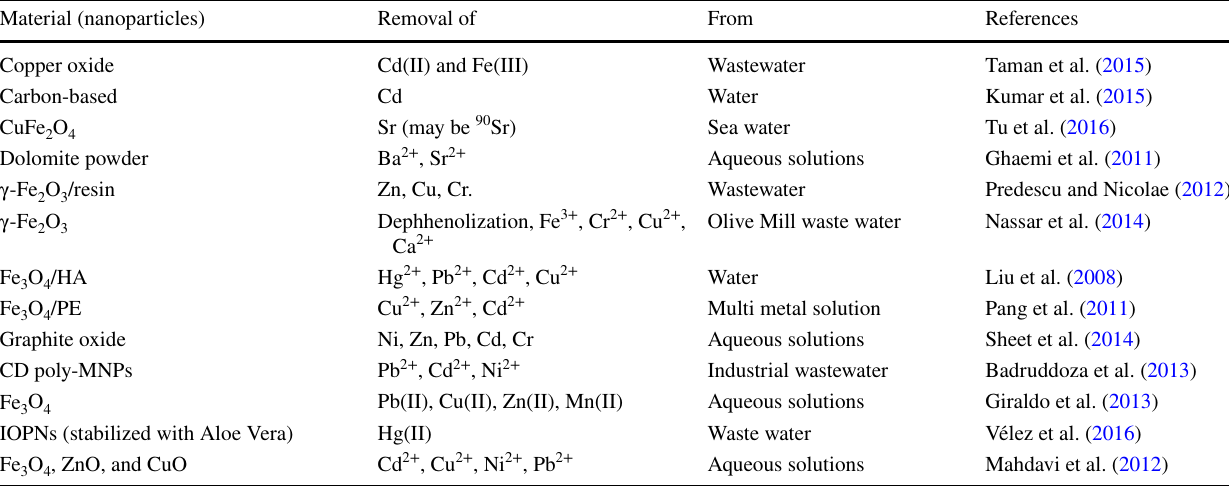
Table 7 Summary of the nanoparticles used for the removal of heavy metals from water/waste water Material (nanoparticles) Removal